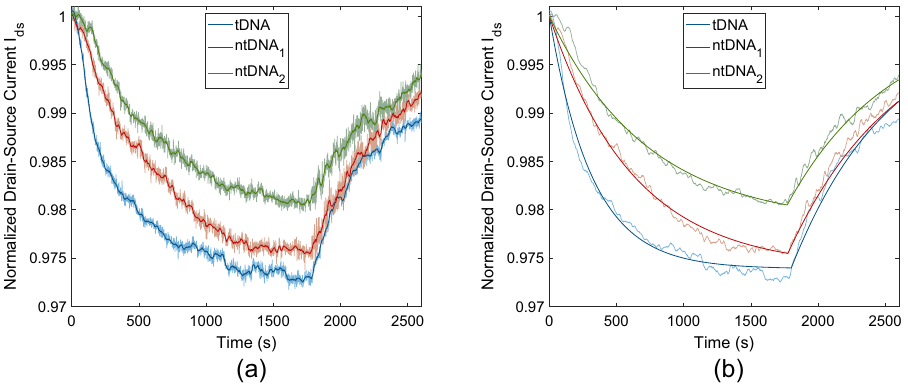
Figure 11. Specificity analysis of the MC receiver. ( a ) Real-time sensing response for complementary tDNA, non-complementary ntDNA 1 with single base-pair mismatch, and non-complementary ntDNA 2 with 7 1800 s, the DNA solutions are replaced with 0.01xPBS solution to base-pair mismatches (see Table 1). At t ≈ allow dissociation of the hybridised DNAs. ( b ) Real-time sensing response fitted by the Langmuir adsorption/ desorption model, Eqs. (7) and